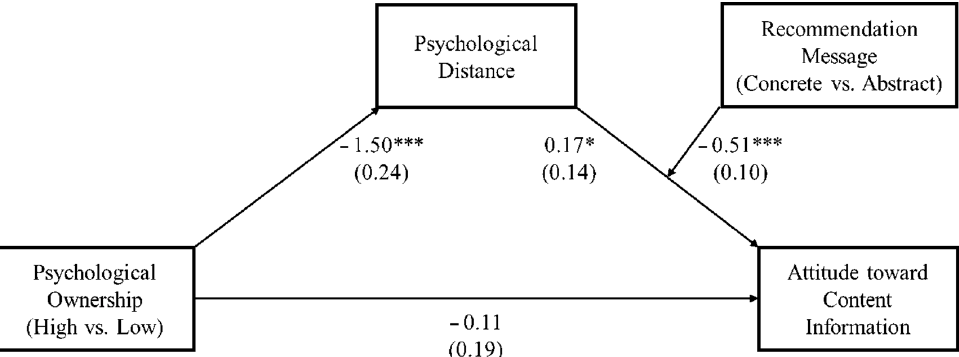
Figure 4. Results of the mediation model of psychological ownership for attitude toward content information through psychological distance. Note. The indirect effect is contingent upon recommen- dation message. Path entries are unstandardized coefficients. Psychological ownership (coded as 0: low, 1: high). Recommendation message (coded as 0: concrete, 1: abstract). * p < 0.05. *** p < 0.001.